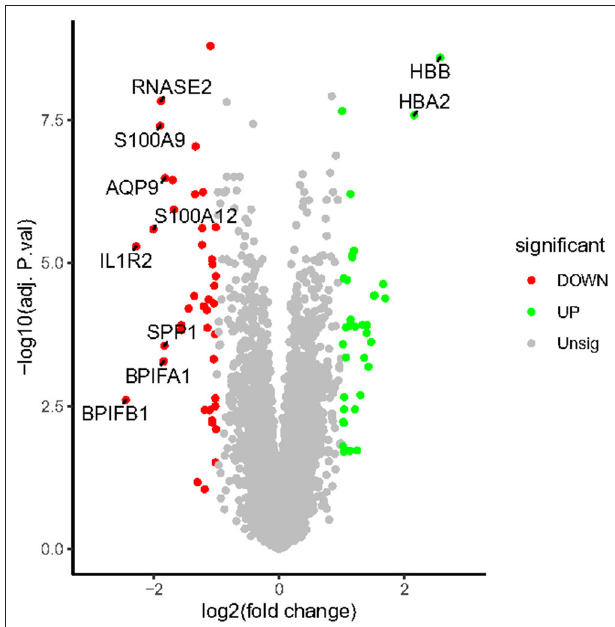
FIGURE 2 | The volcano map of DEGs. The plot compared the DEGs between IPAH patients and controls from the GSE117261 dataset. The red dots represent the down-regulated DEGs; the green dots represent up-regulated DEGs; gray dots indicate the remaining genes that were not significantly changed. Genes signed in the plot are the top ten genes with the most significant